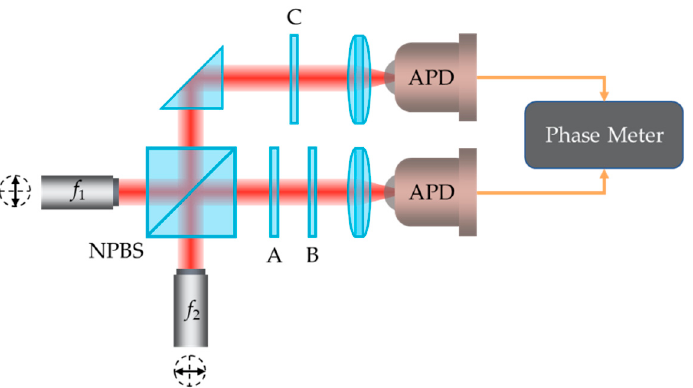
Figure 1. The optical configuration of APD phase drifts error equivalent measurement method.